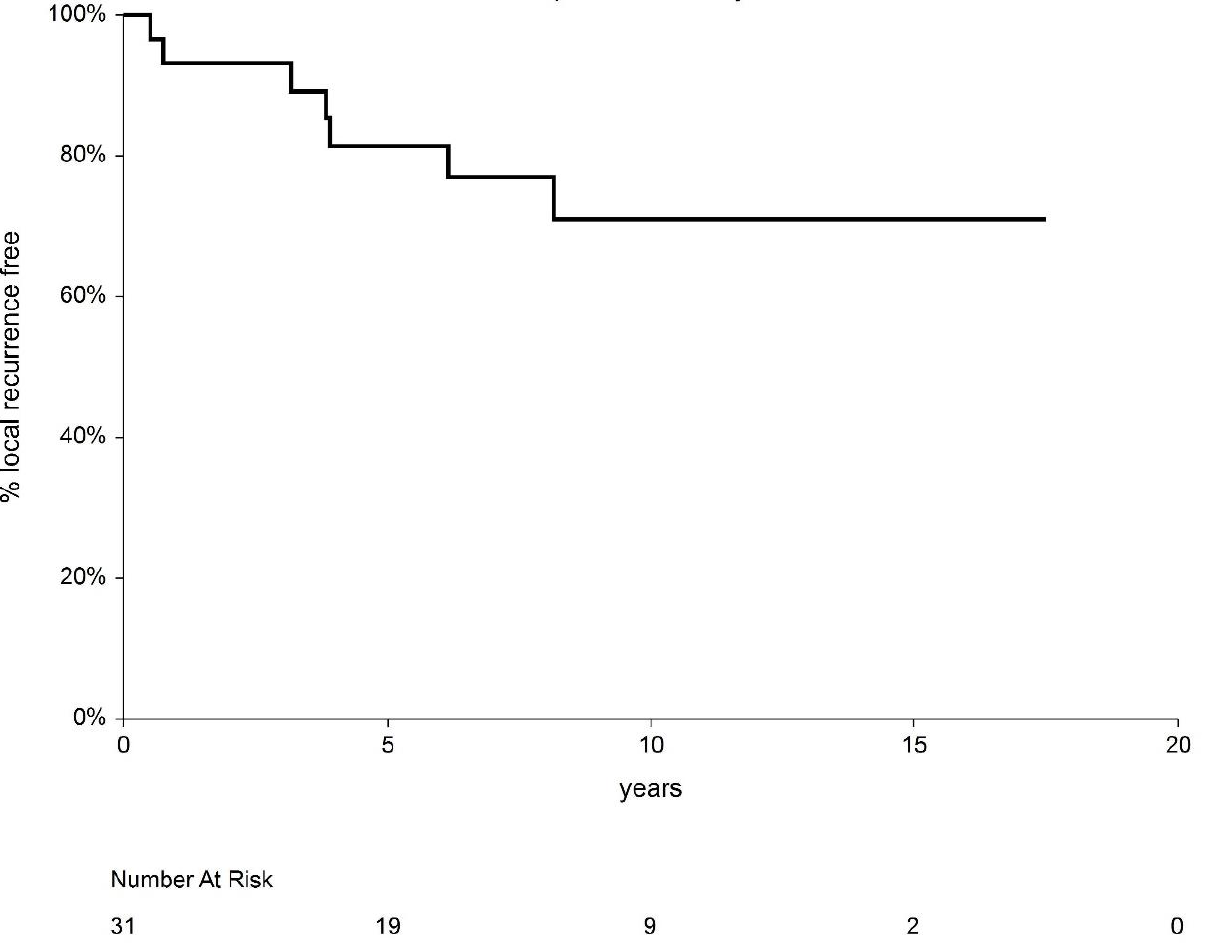
Figure 6. Local control recurrence-free interval after HDR-BT. Penile sparing was achieved in 22 patients; of these, two patients later died (one from a brain tumor and one from cardiac disease). Of these remaining 20 patients, most (17/20; 85%) continue to have an active sexual life that is comparable to their pretreatment status. The probability of penile sparing at 5 and 10 years was 80.6% (95% CI: 63.5–97.7) and 62.1% (95% CI: 34.8–89.4%), respectively (Figure 7).